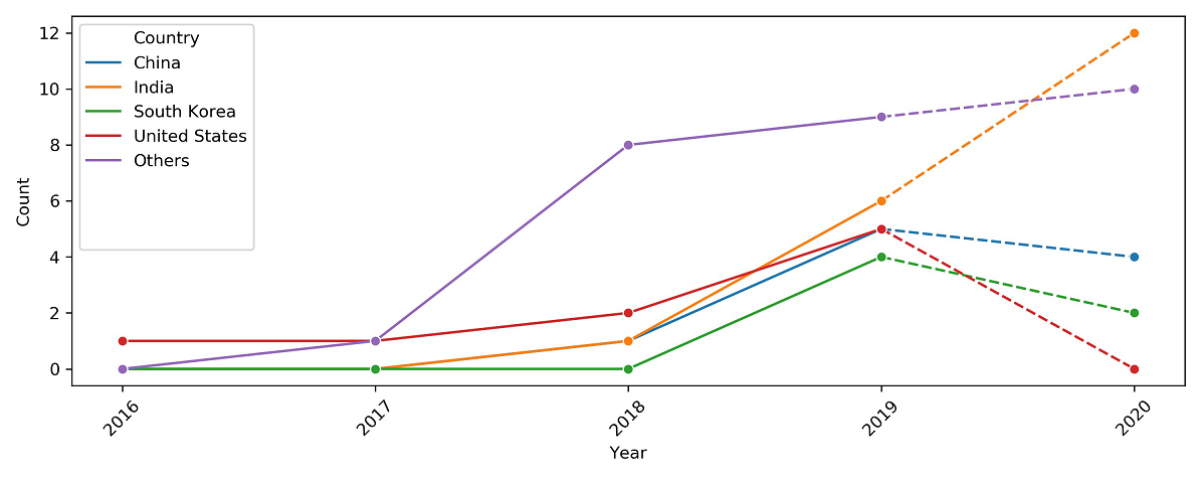
Figure 5. Trend of blockchain personal health record articles by country. Only countries with 5 or more articles in the final review were plotted individually. The other countries were grouped under an Others category. The trend from 2019 to 2020 (represented by dashed lines) is a projection because only data from the first half of the year 2020 was available at the time of the search. Count refers to the number of articles published in that year.